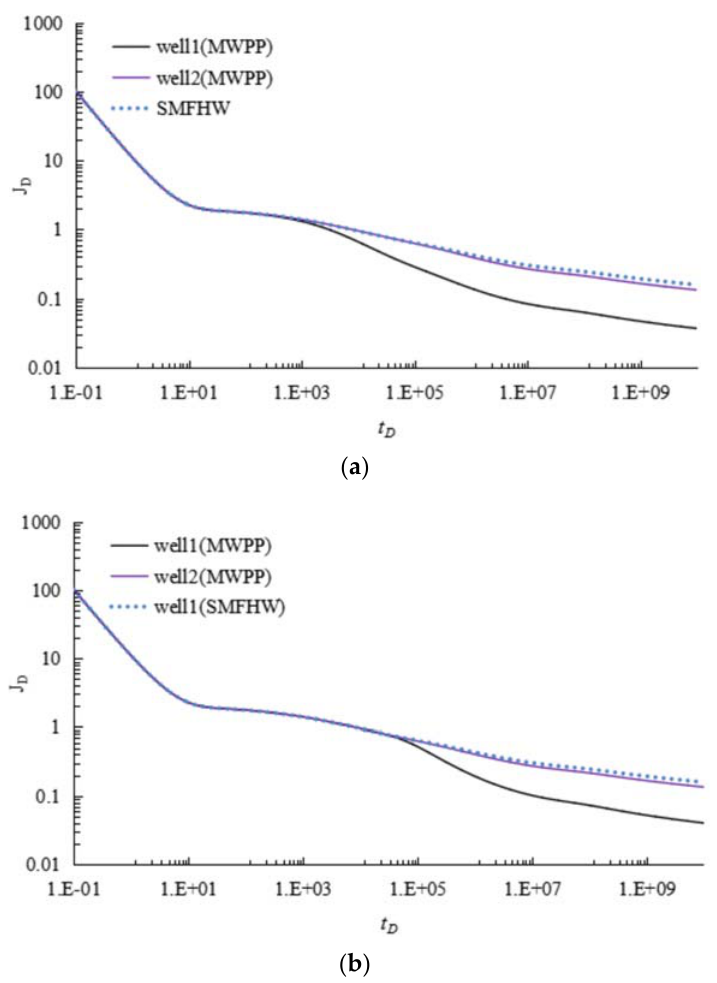
Figure 8. Comparison of productivity Index curves between WIPS and SMFHWs ( q 1 :q 2 = 1:4): ( a ) Figure 1b, case 1; ( b ) Figure 1b, case 2.